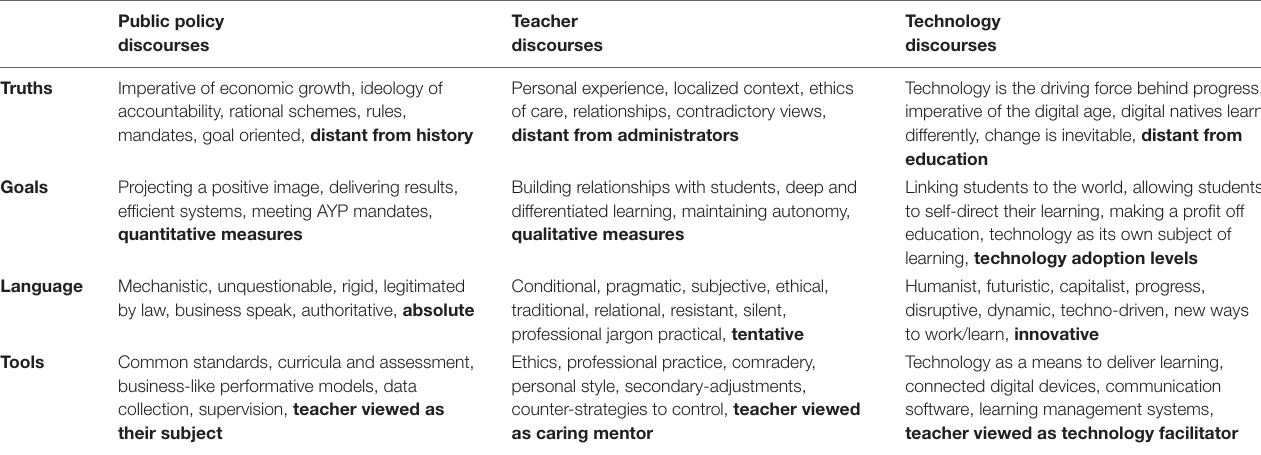
TABLE 1 | Contrasting public policy, teacher and technology